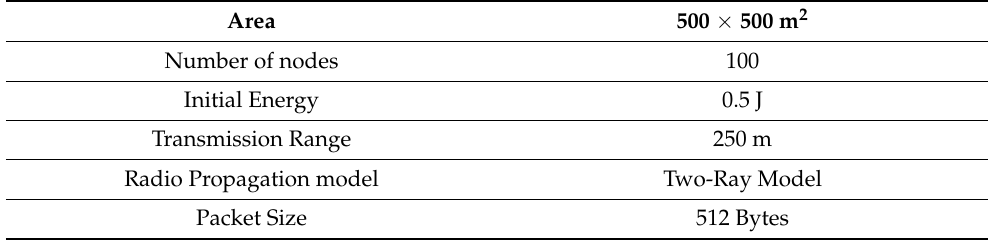
Table 4. Simulation